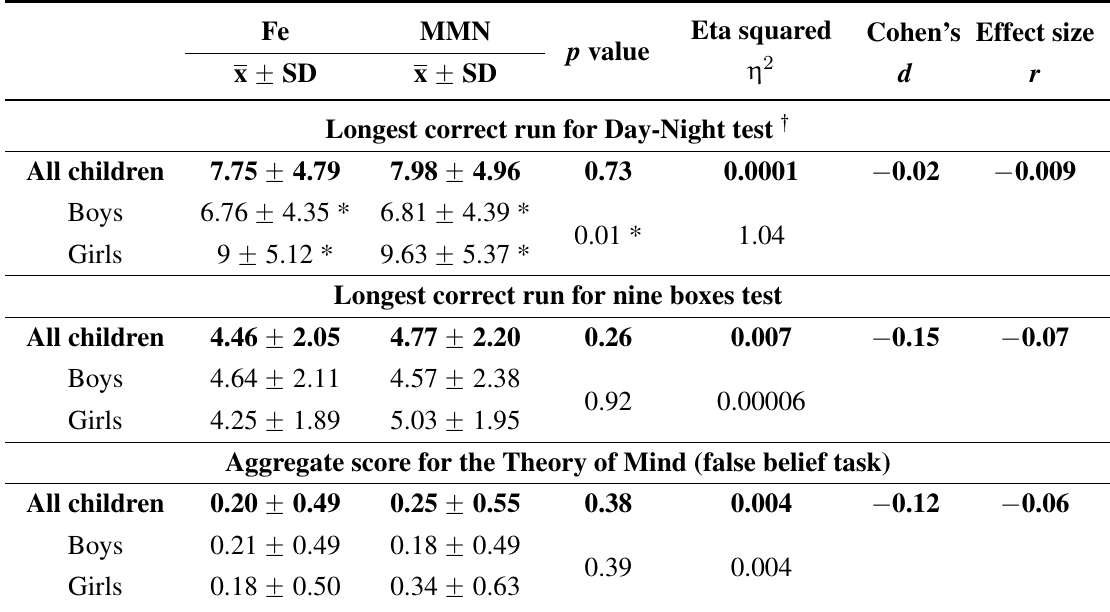
Table 2. Inhibition (Day-Night Stroop test), Working memory (9 boxes) and reasoning (Theory of Mind, false belief task) outcomes by group, and